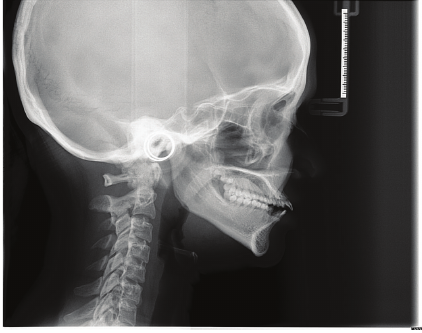
Figure 11: Lateral cephalogram of the